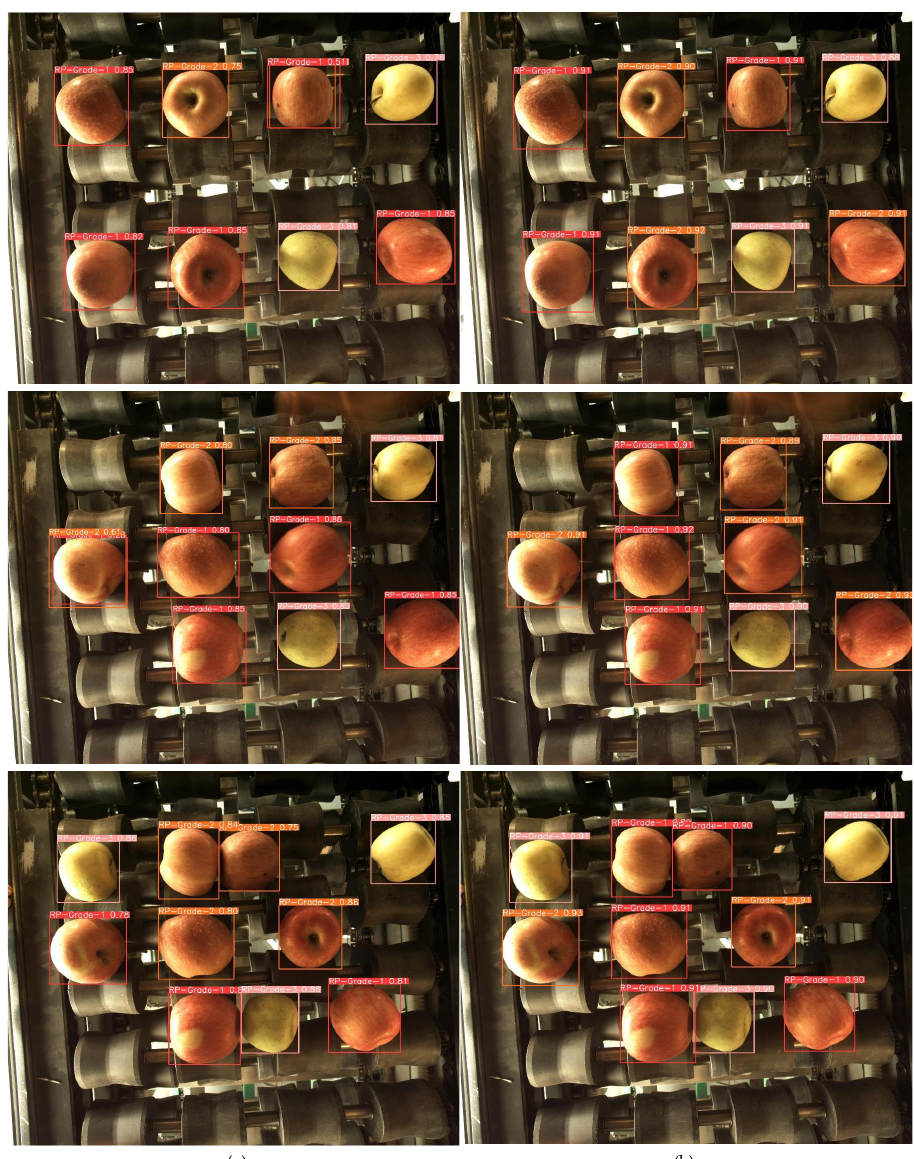
Figure 14. Grading results. ( a ) YOLOv5s model; ( b ) Im-YOLOv5 model.